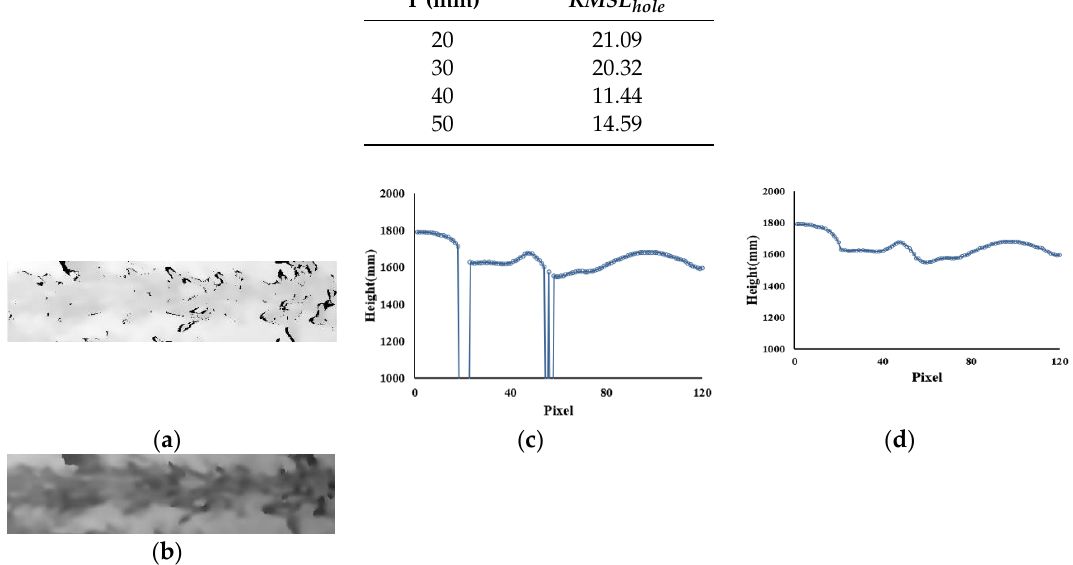
Table 1. Hole-repair algorithm results.